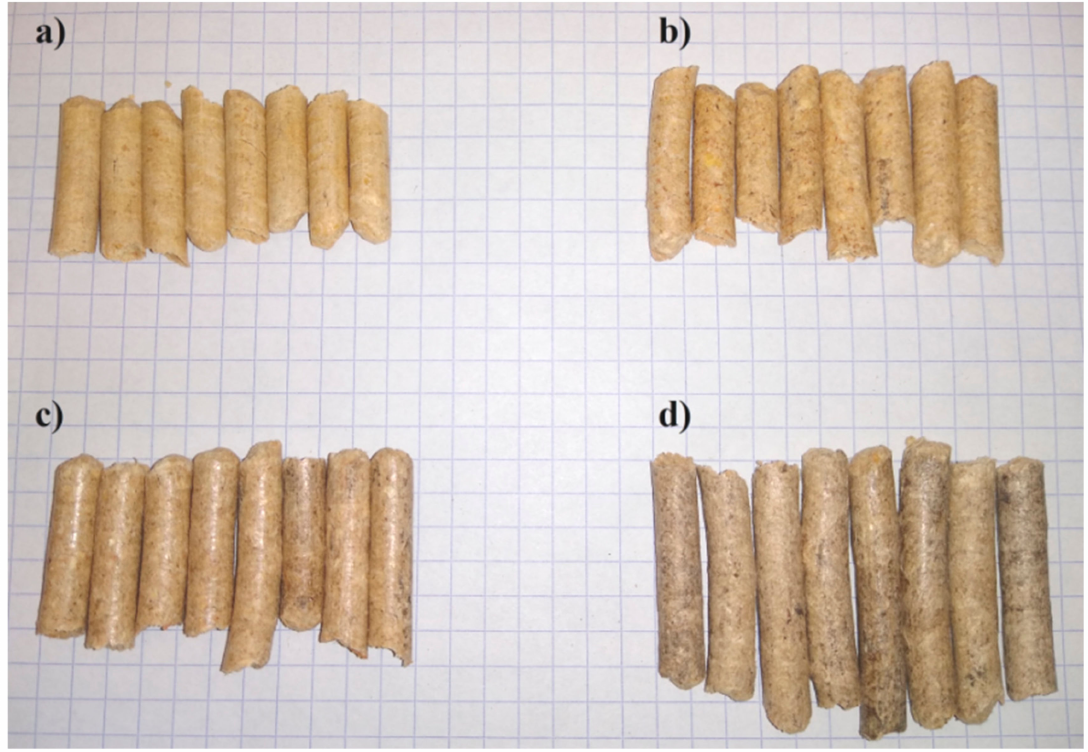
Figure 4. View of the pellets obtained from a mixture of sawdust and different contents of post- flotation dairy sewage sludge: ( a ) 0%, ( b ) 10 %, ( c ) 15%, and ( d )